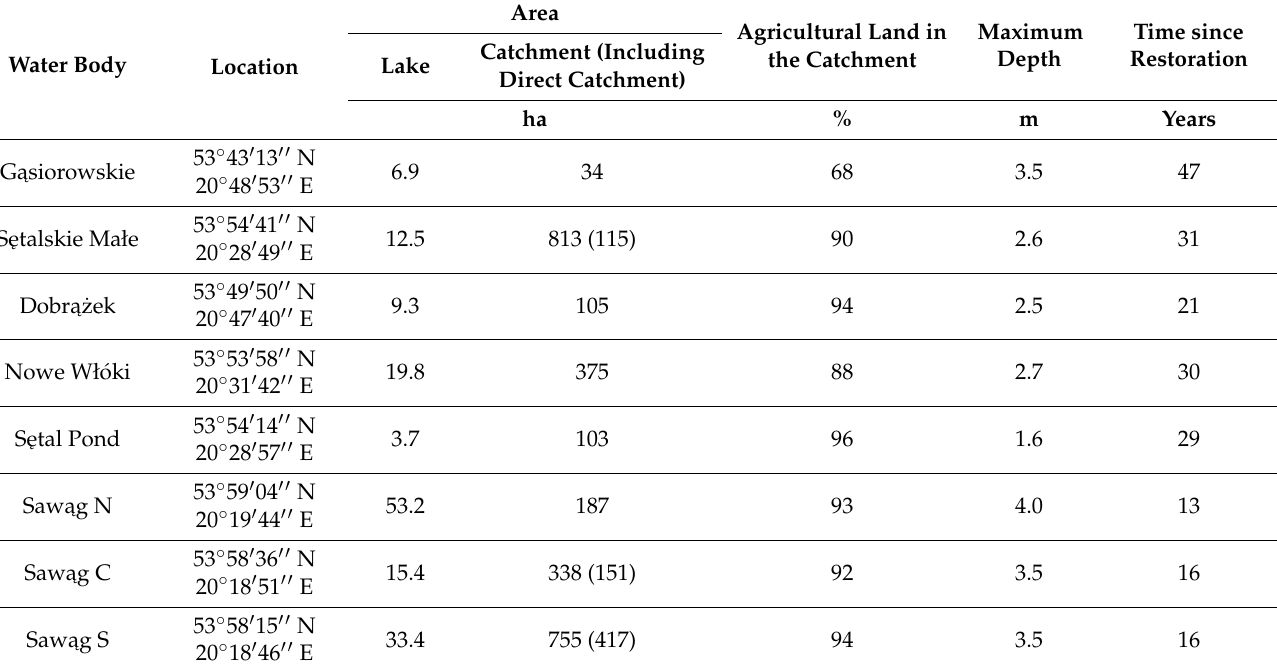
Table 1. Location and characteristics of the analysed water bodies (based on our own